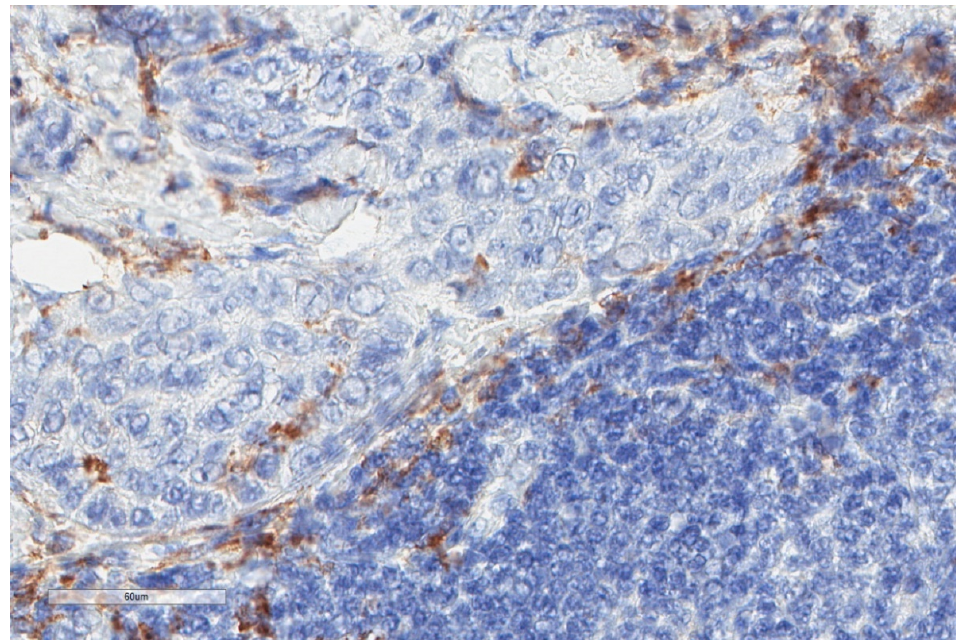
Figure 3. Another case of epithelioid mesothelioma stained for CD163 showing much lower numbers of positive macrophages (X400) .